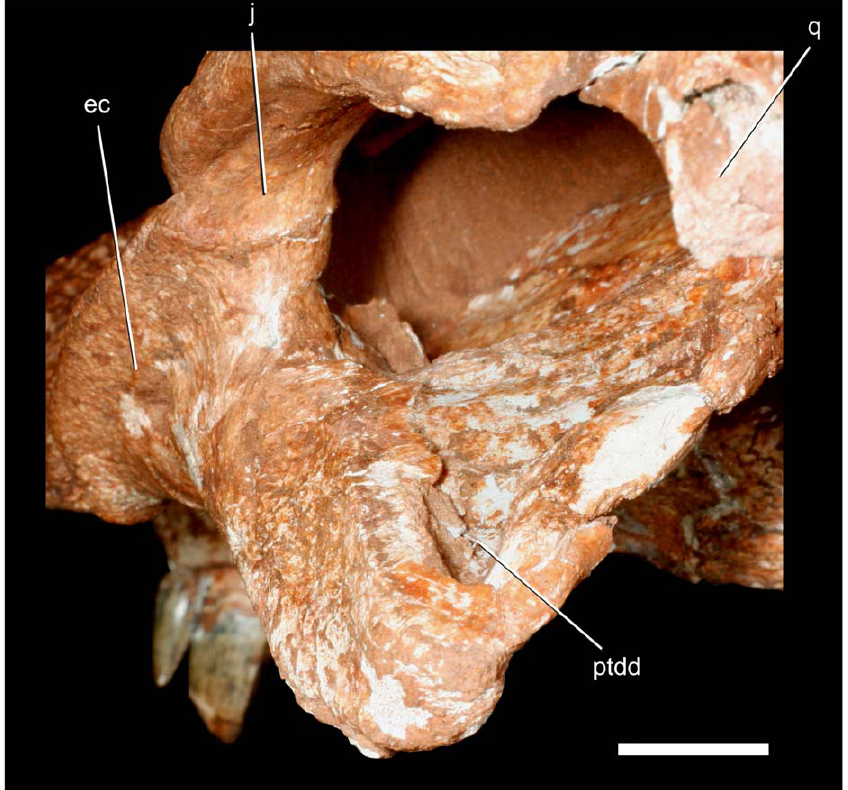
Figure 13. Details of the dorsal surface of the left pterygoid wing of Pissarrachampsasera (LPRP/USP 0019). Image taken from posteroventral view. Scale bar equals 1 cm.